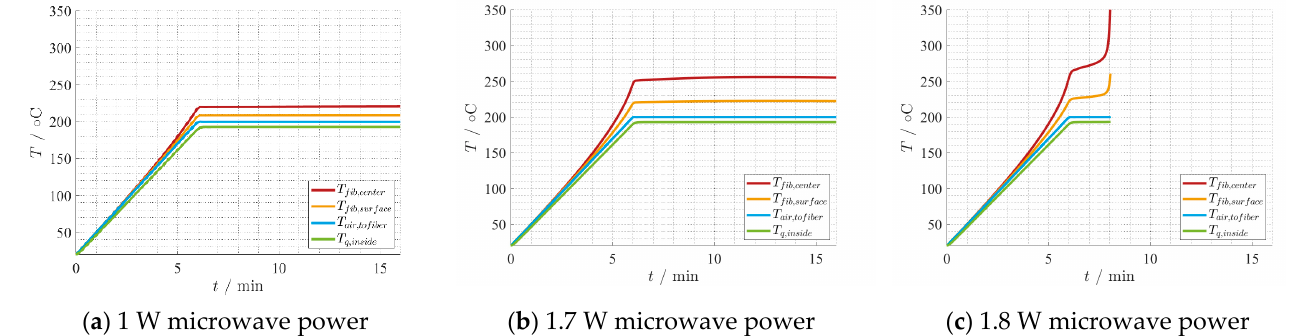
Figure 15. Thermal development depending on 200 °C air temperatures and different microwave power levels over time.